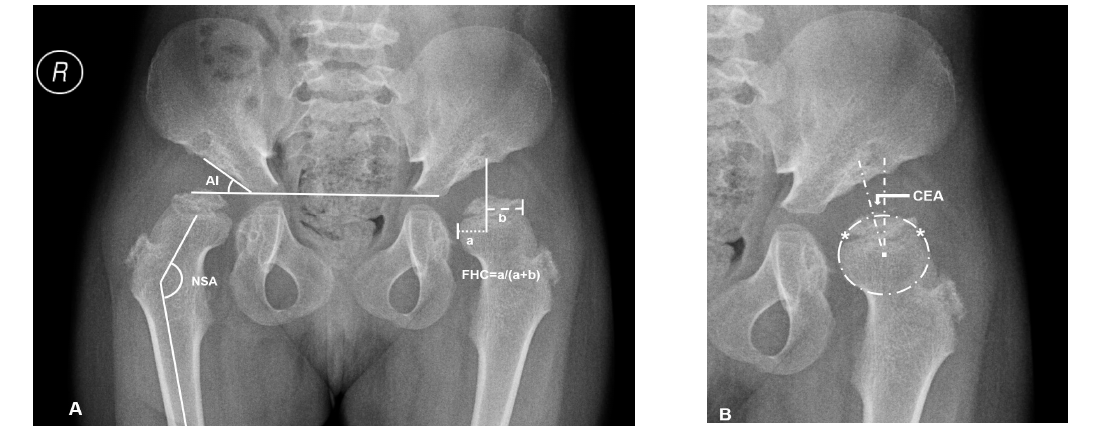
Figure 1. Overview of plain radiographic parameters in a patient with mucopolysaccharidosis (MPS) IVA (No.3: a 6.2-year-old female patient). ( A ) Right hip measurement of the acetabular index (AI) and neck shaft angle (NSA), left hip measurement of femoral head coverage (FHC): ‘a’ is the distance between osseous lateral margin of acetabulum and medial margin of femoral head; ‘b’ is the distance between osseous lateral margin of acetabulum and lateral margin of femoral head. ( B ) The method of Siddesh to define the center of incongruity head. Reference points ‘*’ are marked on the medial and lateral limits of the growth plate. A circle is marked connecting both the reference points, ensuring that the circle just touches the inner margin of the epiphysis but does not extend outside the femoral head. The center of this circle is marked, and then center-edge angle (CEA) is measured.